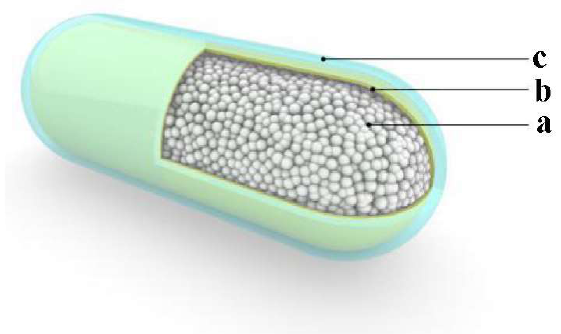
Figure 1. Schematic diagram of the EndoXpand prototype: a is the core expandable material; b is the outer membrane to encapsulate the expandable materials; c is a 000 standard size gelatin capsule shell. The dimensions are: external diameter: 9.55 ± 0.135 mm; length: 26.1 ± 0.3 mm; average wall thickness: 0.145 mm; empty prototype core volume capacity: 1.37 mL; outer membrane wall thickness: 0.035 mm; and gelatin capsule shell wall thickness: 0.11 mm.